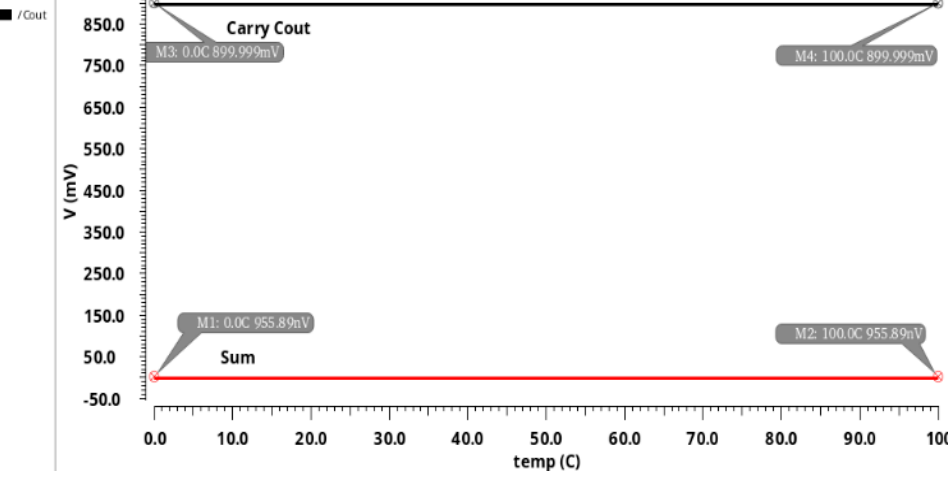
Figure 13. Temperature stability of 10T AA design.